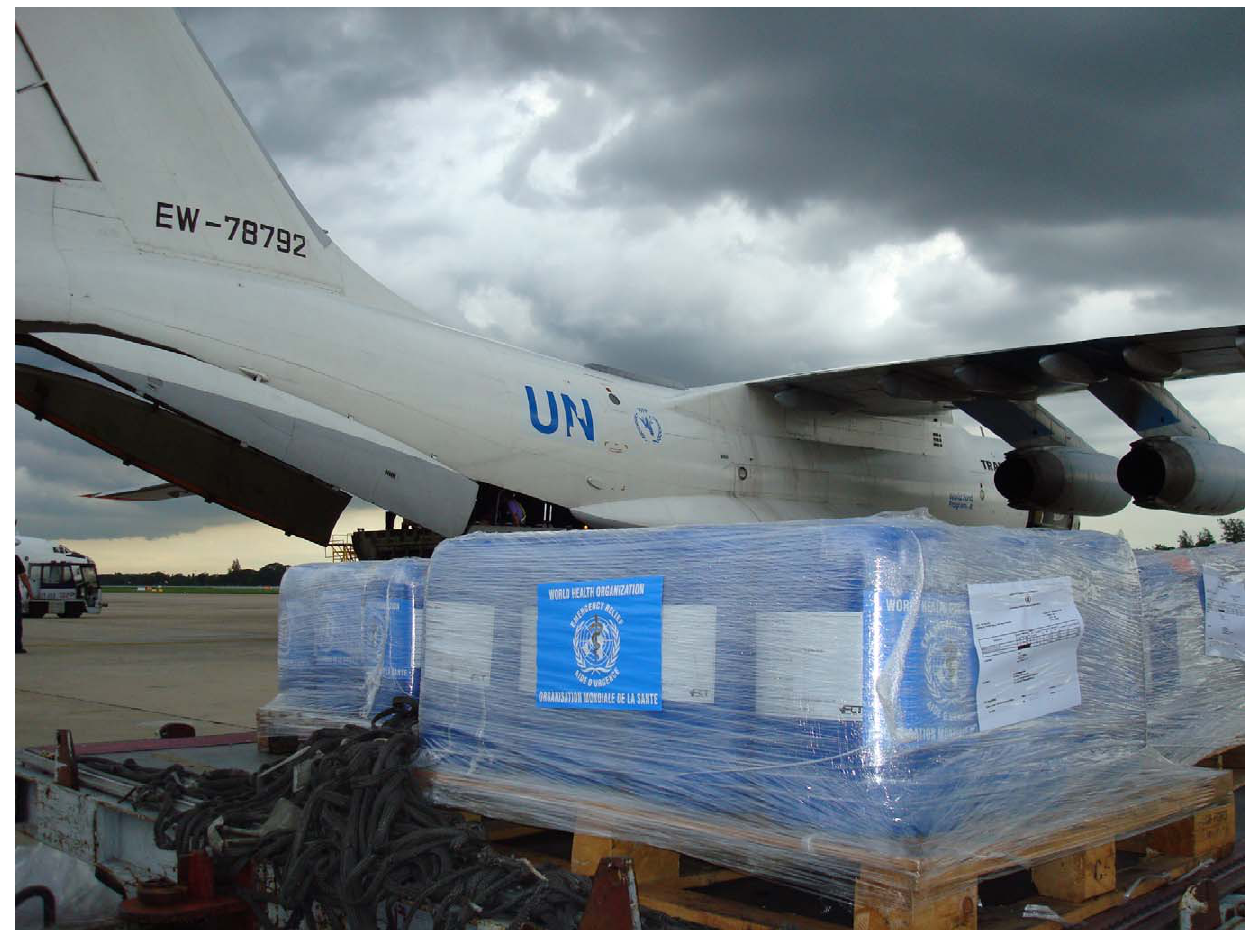
Figure 1. Cyclone Nargis response 2008: Interagency Emergency Health Kits en route to Myanmar. Photo credit: Fred Urlep, WHO.